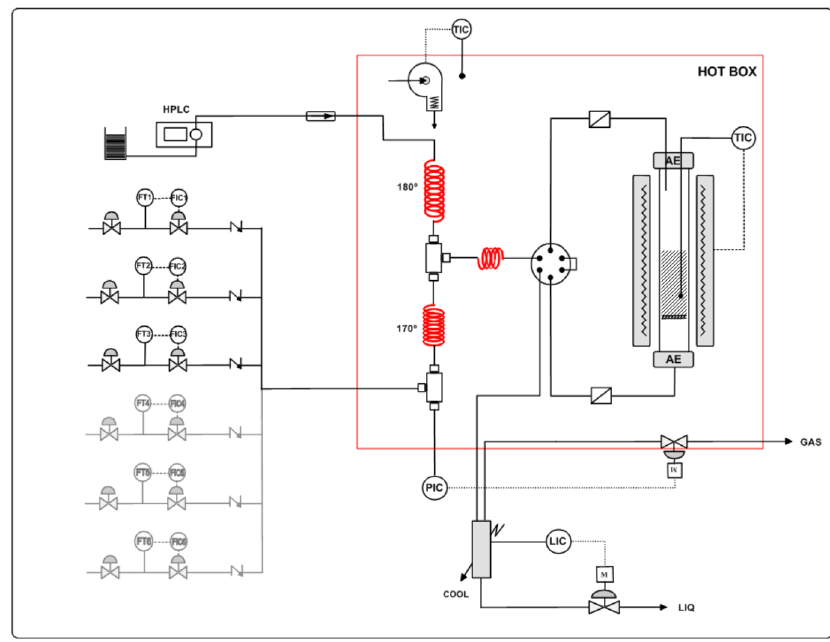
Figure 6. Schematic diagram of the micro activity-reference reactor